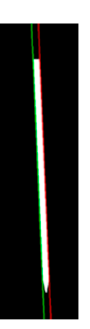
( c ) Figure 11. Detection of rotated cutting blade. ( a ) Acquired image; ( b ) generalized bounding box used for image detection; ( c ) minimum rotated rectangle bounding box for image detection. The thickness and length of the cutting blade can also be measured by using the minimum